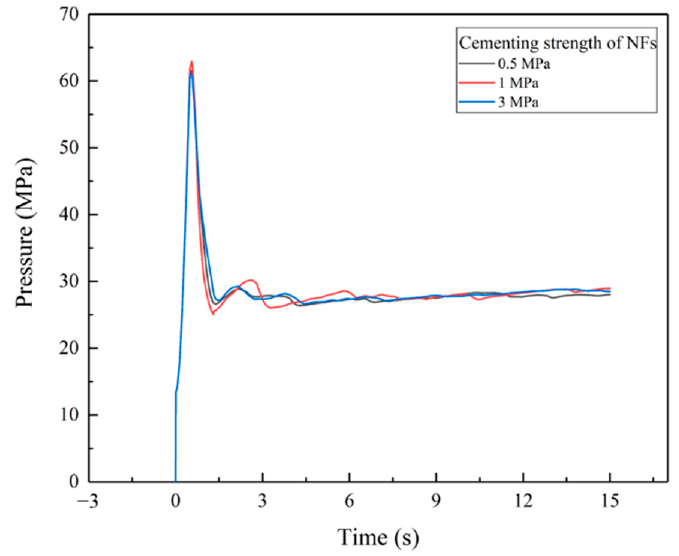
Figure 22. The bottom hole pressure under different cementing strengths of natural fractures.